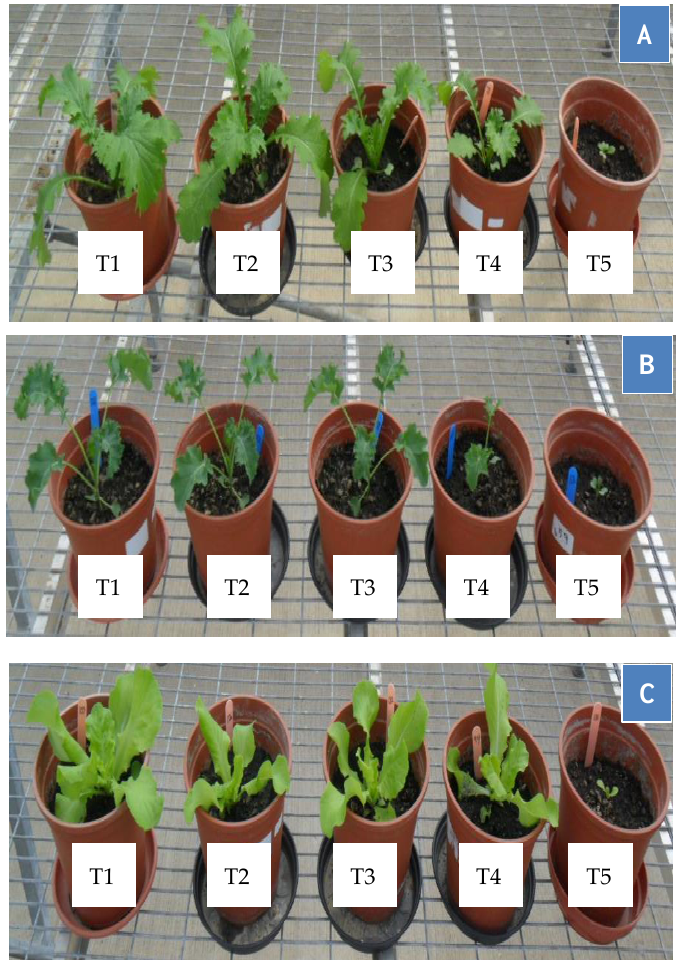
Figure 3. The growth of three green leafy vegetables (( A ) B. juncea , ( B ) B. oleracea and ( C ) L. sativa ) in pots containing crude oil at different concentrations. Treatments T1, T2, T3, T4 and T5 are 0 mg/kg TPH (Control), 1500 mg/kg TPH, 3000 mg/kg TPH, 5000 mg/kg TPH, and 10,000 mg/kg TPH, respectively. Source: Odukoya [5].